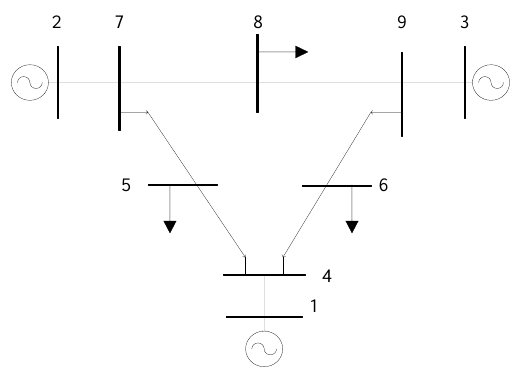
Energies 2019 , 12 , x FOR PEER REVIEW Figure 3. Structure diagram of IEEE-9 bus system. Figure 3. Structure diagram of IEEE-9 bus system.